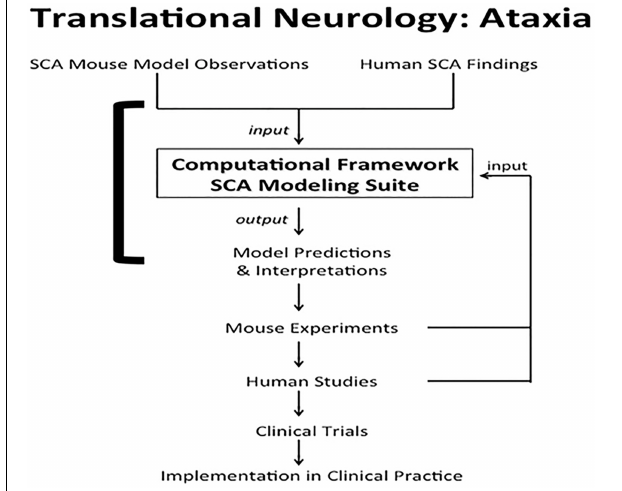
FIGURE 1 | Translational neurology: ataxia. SCA mouse observations and human SCA findings are incorporated into the computational framework SCA modeling suite. The models help interpret experimental and clinical findings. The models also predict interactions between proteins and emergent properties that can be borne out in novel mouse experiments. Results from the laboratory and clinical observations can be used to validate, disprove, or tweak the computational models. Findings from mouse experiments can also ultimately be translated to human studies, leading to clinical trials to test therapeutics. The final step in translational neurology with the example of ataxia is implementation of the iterative findings in patient care. The solid square bracket highlights the components addressed directly by computational systems neurobiology (Brown et al., 2012; Brown and Loew,